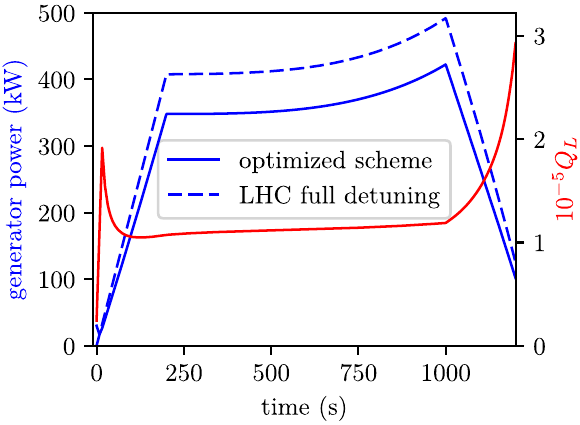
FIG. 12. Evolution of the generator power and the loaded quality factor during the ramp for the energy program and the filling factor shown in Fig.